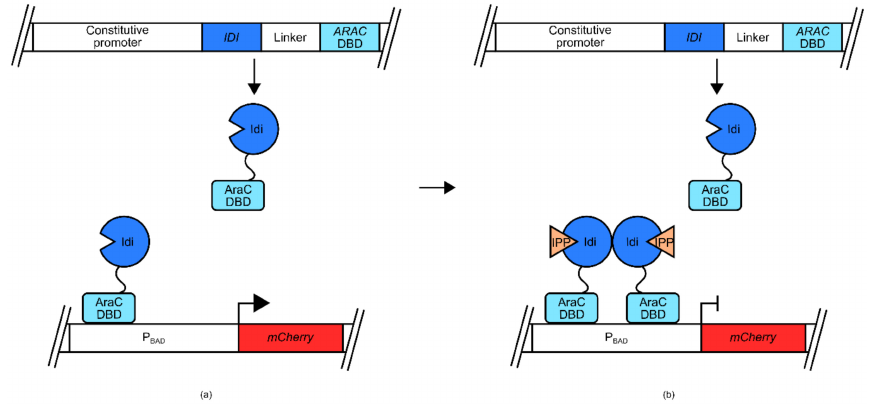
Figure 4. Isopentenyl-pyrophosphate (IPP) biosensor for use in E. coli. An IPP isomerase (Idi) domain- tether-AraCDNAbindingdomainfusionproteinwasexpressedundertheregulatorycontrolofaconstitutive promoter. Whilst an mCherry gene was under the regulatory control of P BAD : ( a ) Under low IPP concentrations, Idi-linker-AraC DNA binding domains (DBD) fusion protein associated with P BAD and the AraC DBD induced transcription of mCherry; ( b ) Under increased IPP concentrations, Idi-mediated fusion protein dimerization inhibited the ability of AraC DBD from efficiently inducing transcription of mCherry . Thus, increases in IPP concentration were correlated with decreases in the mCherry signal.